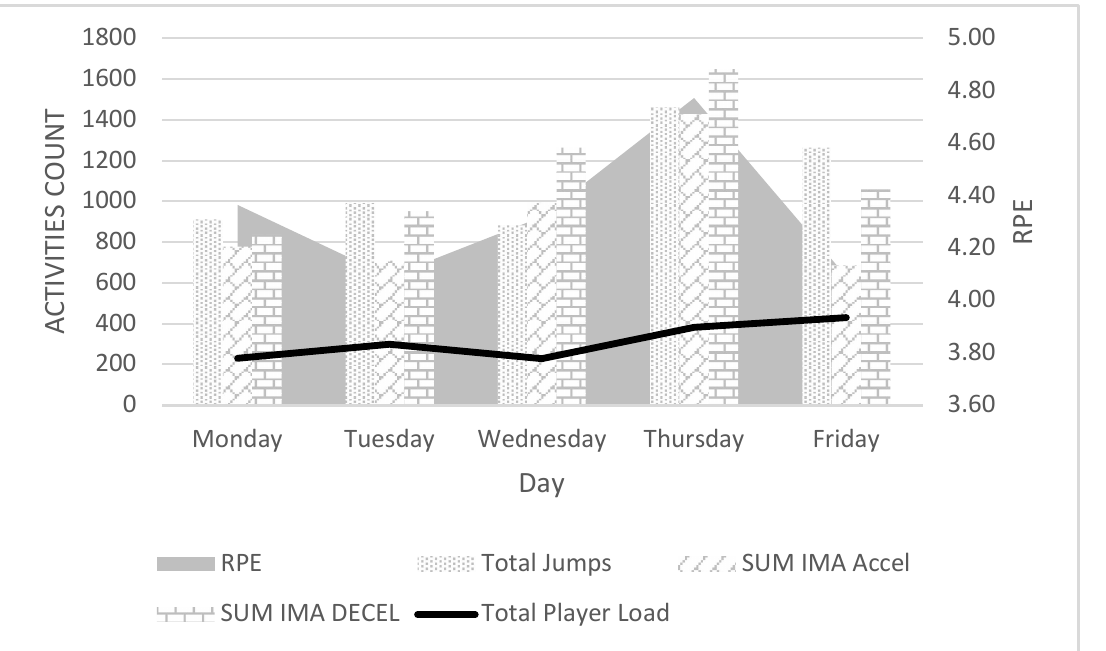
Figure 3. Correlations between RPE and ETL factors. Rating of Perceived Exertion (RPE), External Training Load (ETL), Inertial Movement Analysis Accel/Decel (IMA Accel/Decel).